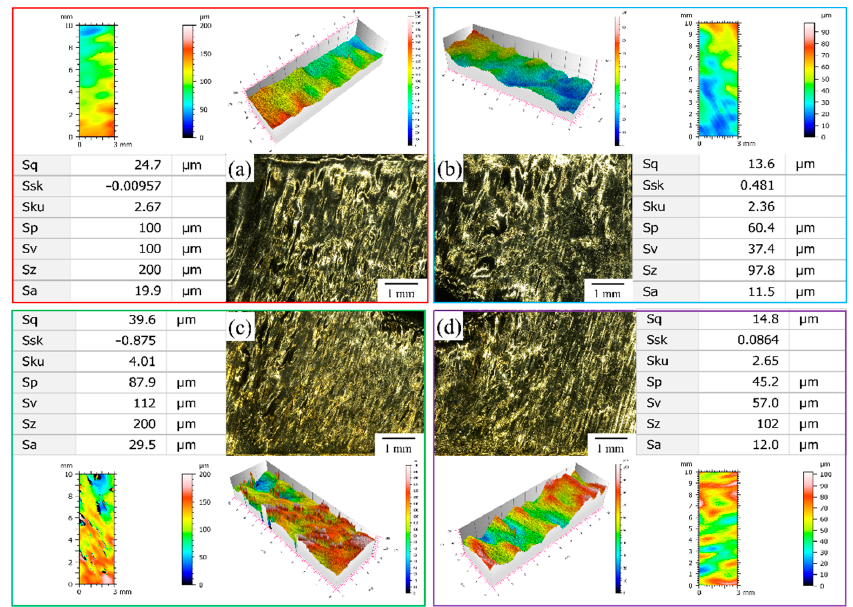
Figure 8. Schematic diagram of specimen roughness partition.